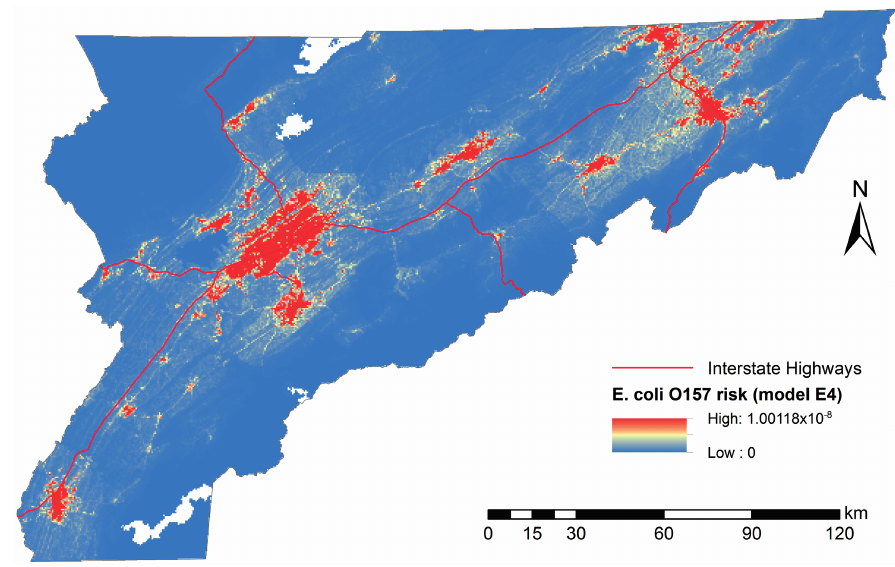
Figure 4. Spatial logistic regression model (E4) risk map for E. coli O157 infection (see Table 3 for the